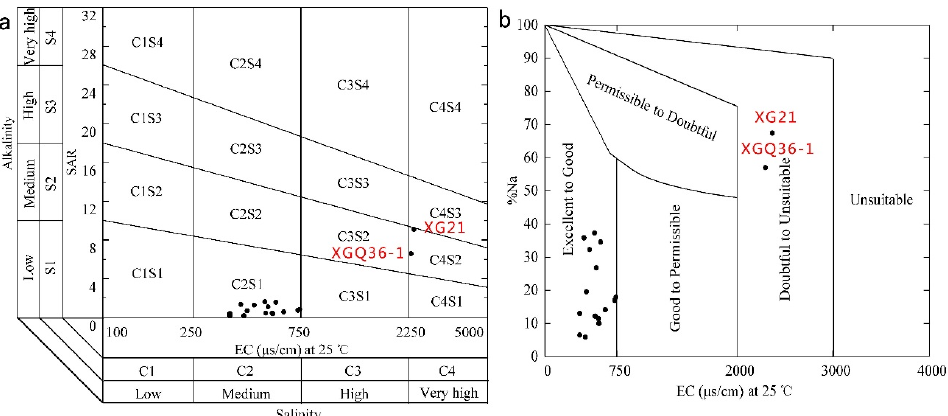
Figure 6. USSL ( a ) and Wilcox ( b ) diagrams of samples.